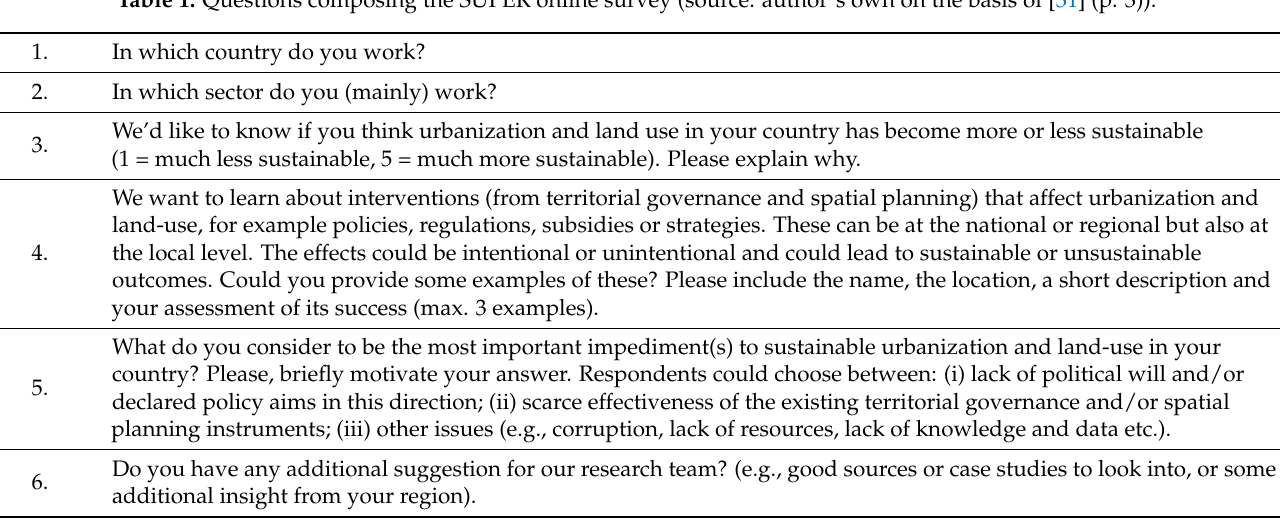
Table 1. Questions composing the SUPER online survey (source: author’s own on the basis of [31] (p.